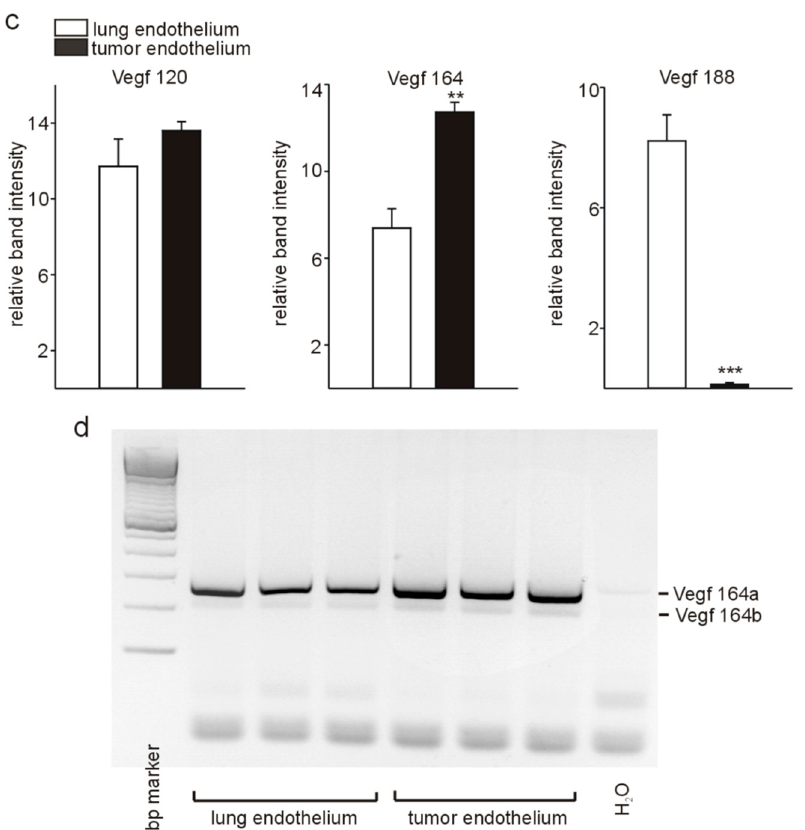
Figure 1. Differential expression of Wt1, Srpk1, and Srsf1, and Vegf splicing in tumor versus normal lung endothelium. ( a ) Quantitative RT-PCR analysis of Wt1, Srpk1, and Srsf1 expression in isolated tumor versus lung endothelial cells ( n = 3 each). ( b ) Detection of Vegf isoforms ( n = 3) was performed by RT-PCR followed by agarose gel electrophoresis as described [18]. A representative example is shown. The different molecular weight isoforms are indicated (Vegf 188: 293 bp; Vegf 164: 221 bp; Vegf 120: 89 bp). ( c ) Quantification of the different Vegf isoforms in isolated tumor and lung endothelial cells. ( d ) Detection of the Vegf 164a (281 bp) and Vegf 164b (215 bp) isoforms was performed by RT-PCR followed by agarose gel electrophoresis as reported previously [26] ( n = 3). Data are expressed as means ± S.E.M. * p < 0.05, ** p < 0.01, *** p <